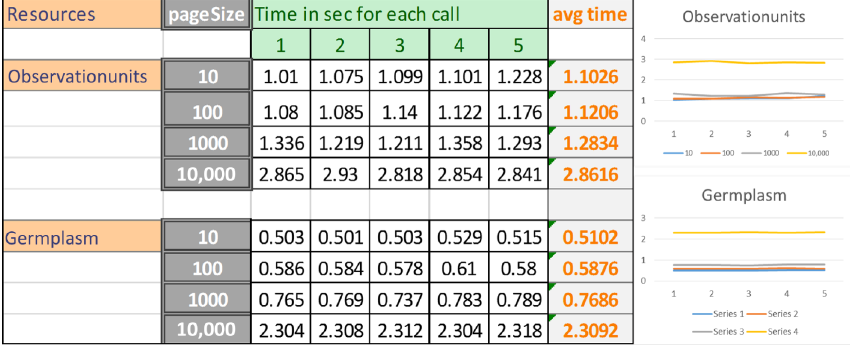
Figure 9: Performance test on large data-sets such as germplasm and observation